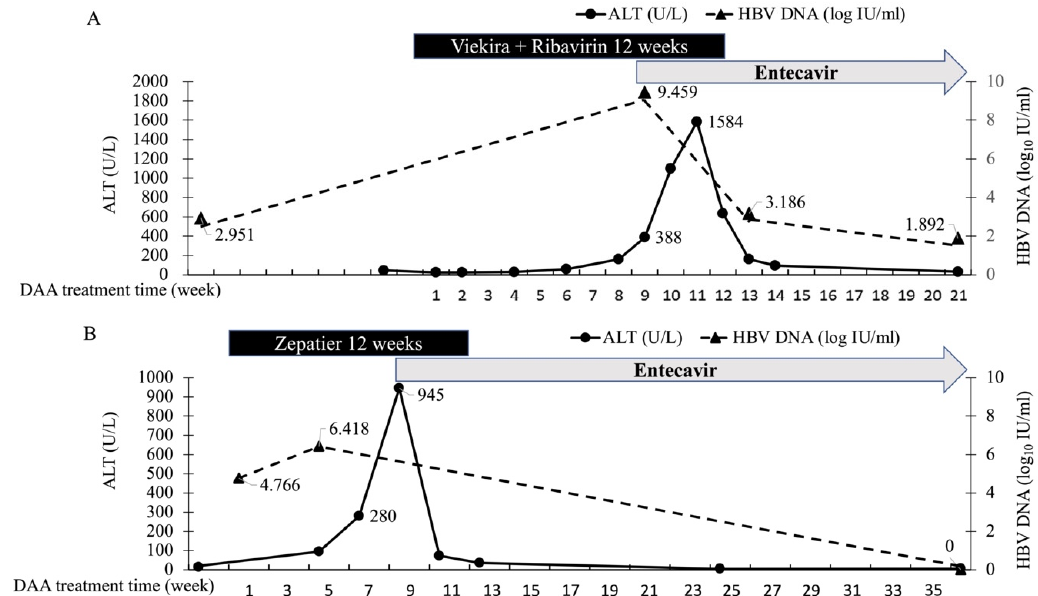
Figure 2. Figure 2. ALT and HBV DNA level in patients develops HBV flare during DAA Treat- ment. ( A ) A 52 years old male, non-cirrhotic, encountered asymptomatic ALT elevation up